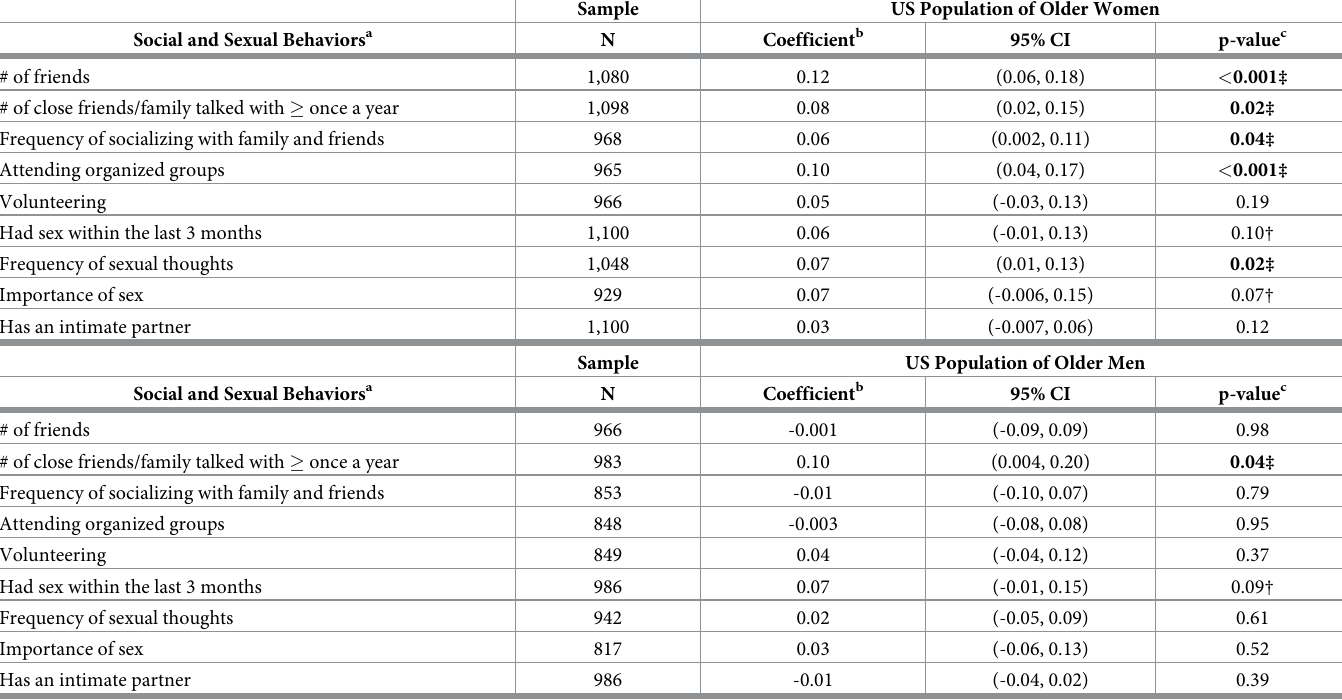
Table 4. A. Women: Associations between androstadienone sensitivity and their social and sexual behaviors. B . Men: Associations between androstadienone sensitiv- ity and their social and sexual behaviors. (NB Tables are large and at the end of the manuscript).